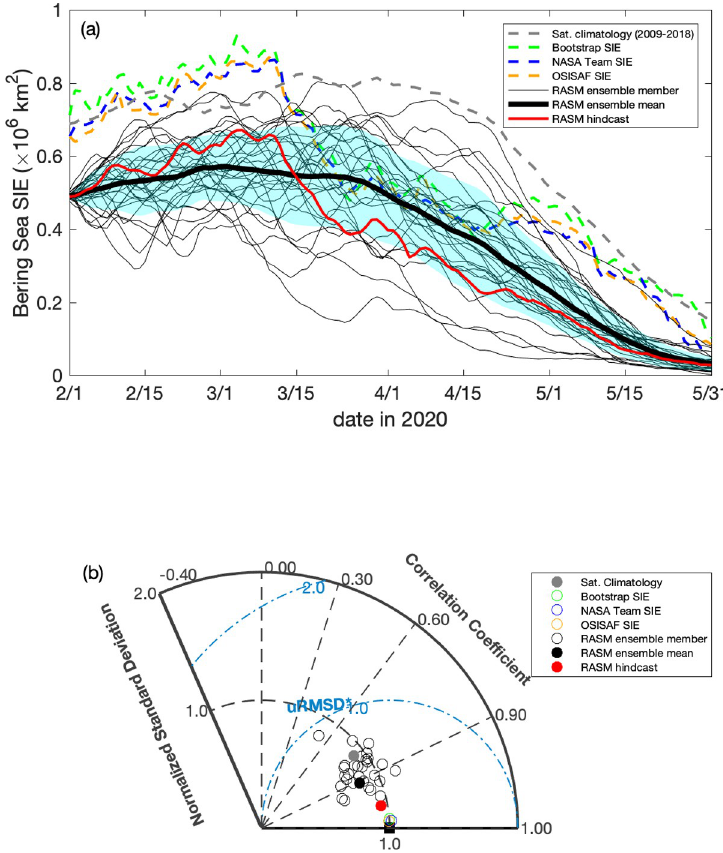
Fig 16. Daily sea ice extent during February–May, 2020 from RASM compared with satellite observations. (a) Daily timeseries of sea ice extent in the Bering Sea during February to May, 2020 from the RASM forecast, RASM hindcast, and satellite algorithms, with light blue shading representing 1 standard deviation from the forecast ensemble mean. The gray dashed line is the satellite-derived (Bootstrap, NASA NT, and OSISAF) daily climatology between 2009 and 2018. (b) Taylor diagram showing the normalized correlation coefficient (r), standard deviations ( σ ), and the unbiased root-mean-square difference (uRMSE) for the timeseries. The Taylor diagram illustrates a relative model performance in reproducing satellite-derived Bering Sea daily SIE variability, as well as the individual data sets, relative to the average of Bootstrap, NASA NT, and OSISAF products, represented by the black square as the reference where the normalized standard deviation and the correlation coefficient are 1.00 and the unbiased root mean difference is 0.00. Figure created using Matlab (v. 2018a).